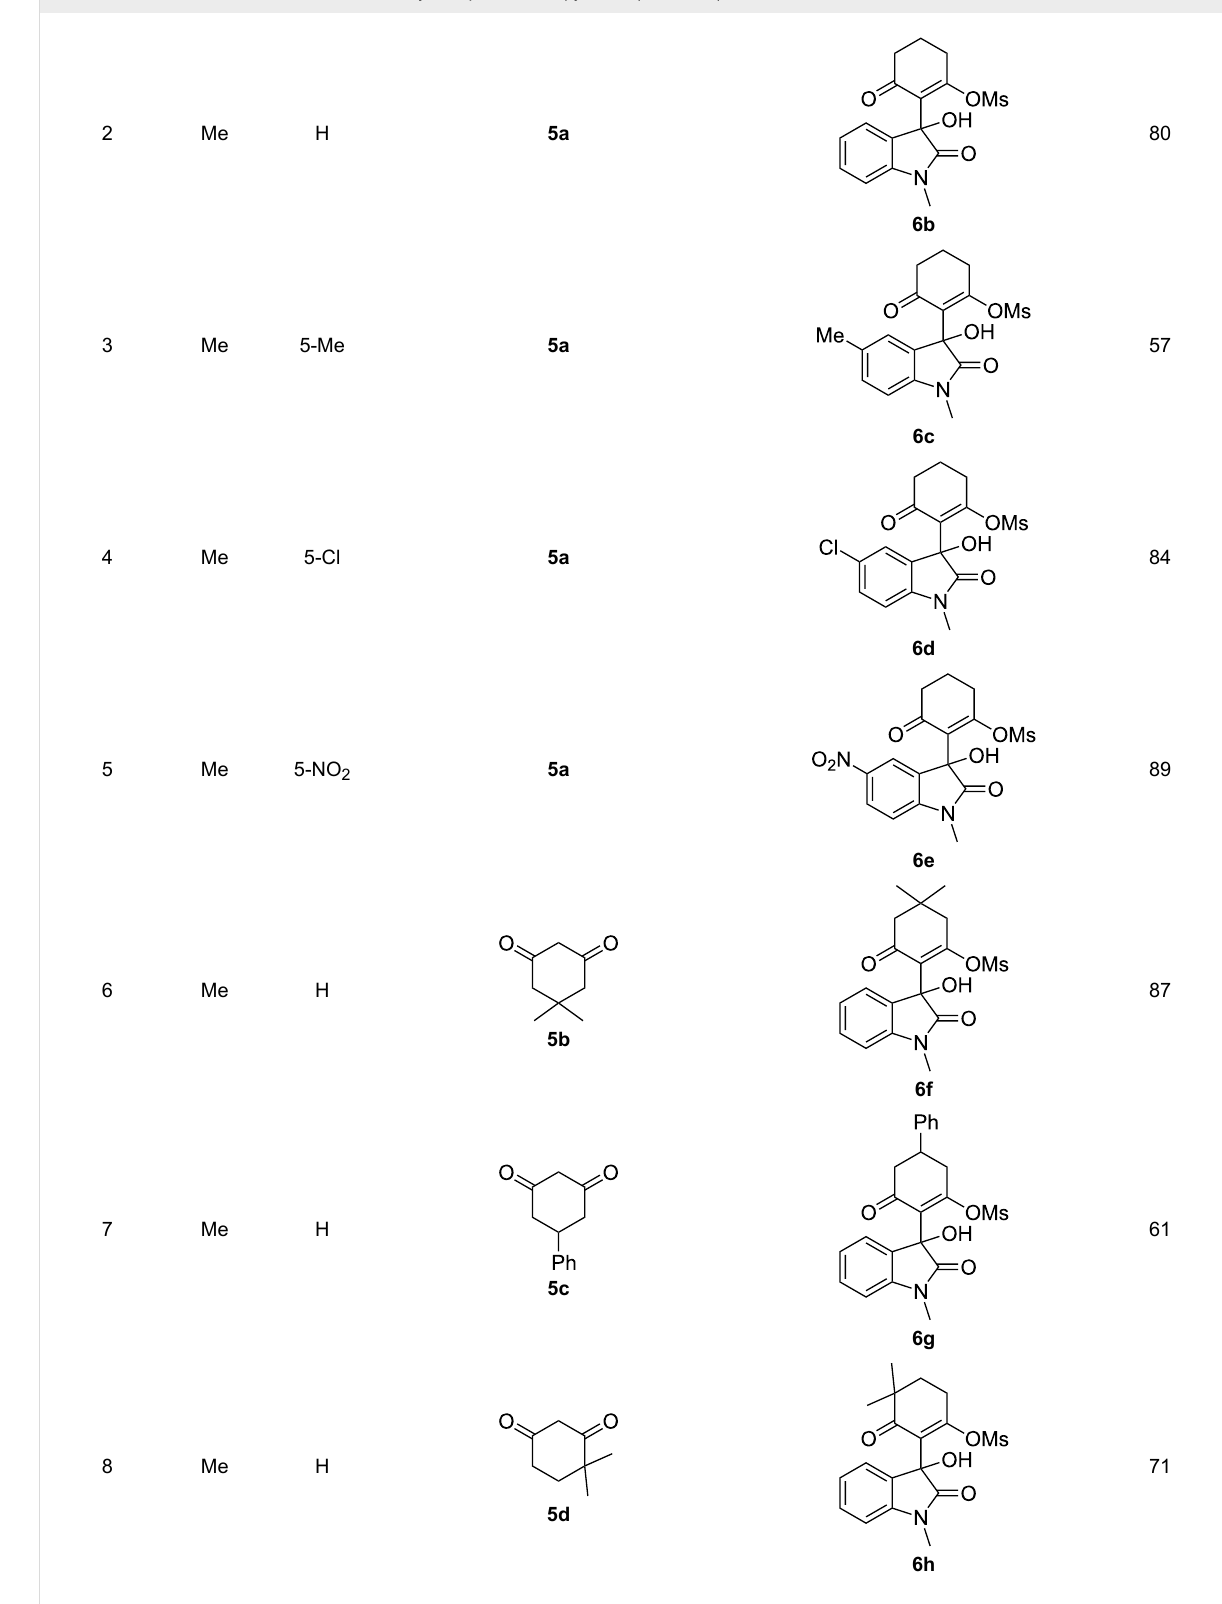
Table 1: Reaction of isatins 4 and 1,3-dicarbonyl compounds 5 in pyridine.